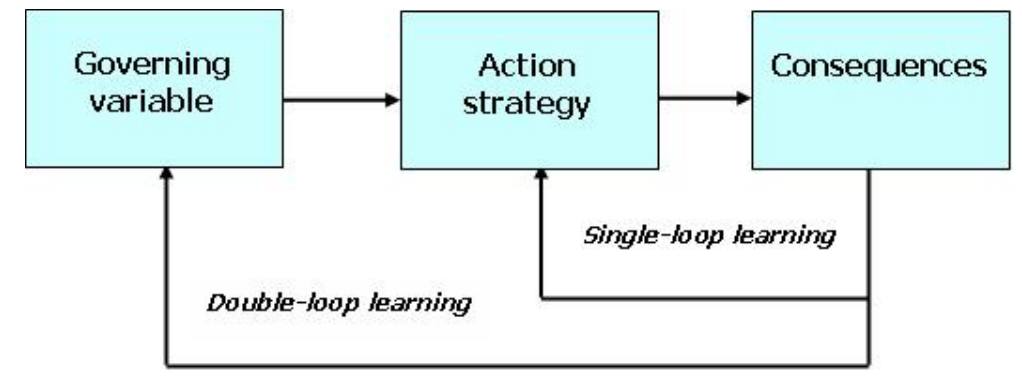
Figure 1. Single-loop and double-loop organisational learning (based upon Argyris and Schön,